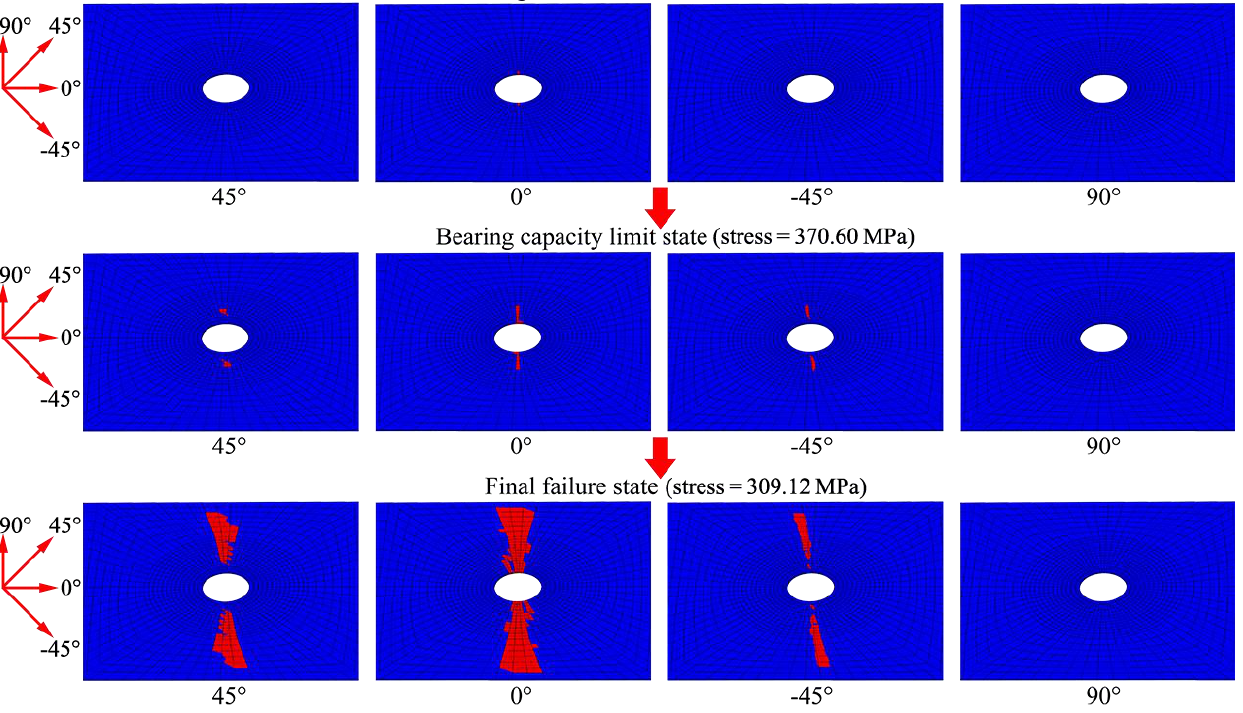
Figure 9. Illustration of matrix damage evolution at four plies of the second sub-laminate in different loading